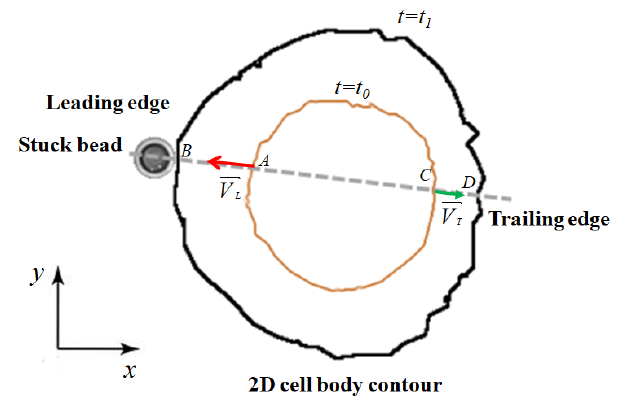
Figure 2. Cell movement (velocity and trajectory) model of HT29 cell stimulated with EGF-coated and non-EGF-coated bead stuck onto the cover glass surface. The grey dotted line extending from the center of the stuck bead to the closest point to the edge of the cell (leading edge) and extending to the distal part of the cell region (trailing edge) is defined as the chemosensing axis. The 2D cell body contours are also plotted at time points t 0 and t 1 , highlighted with an orange and a black line, respectively. The ratio of velocity magnitudes, |𝑉 𝐿 ⃑⃑⃑ |/|𝑉 𝑇 ⃑⃑⃑⃑ | , was applied to quantify cancer cell chem- otaxis and response to TKI PD153035 at the single-cell level, where 𝑉 𝐿 ⃑⃑⃑ and 𝑉 𝑇 ⃑⃑⃑⃑ represent the prop- agation speeds at the leading and trailing edges.